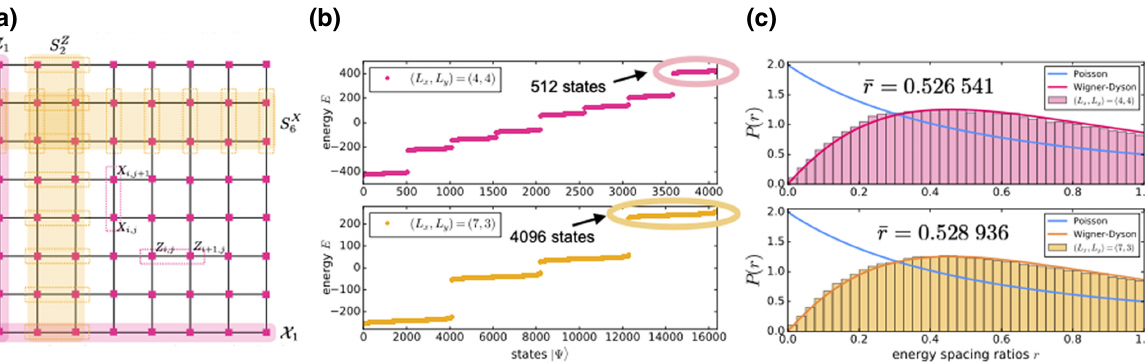
FIG. 6. The Bacon-Shor model. (a) Qubits (magenta squares) living on a square lattice with gauge generators X i , j X i , j + 1 and Z i , j Z i + 1, j highlighted by dashed rectangles. Examples of the stabilizer generators S X and S Z , i.e., S X and S Z , are highlighted in yellow and the j i 6 2 logical operators Z 1 and X 1 , each being a product of Z ( X ) operators along a vertical (horizontal) path, are highlighted in magenta. (b) The energy spectra for two systems of size ( L x , L y ) = ( 4, 4 ) (top panel) and ( 7, 3 ) (bottom panel) containing a total of 16 384 and 4096 states, respectively, are shown. The spectrum splits into eight (four) parts for ( L x , L y ) = ( 4, 4 ) , ( 7, 3 ) , each separated by a relatively large energy difference. A single sector of the spectrum contains 512 states for ( L x , L y ) = ( 4, 4 ) and 4096 states for a ( 7, 3 ) system. (c) The histograms of energy-level spacing ratios r are depicted again for the systems of size ( 4, 4 ) (top panel) and ( 7, 3 ) and J z is employed by uniformly (bottom panel). In order to lift any accidental degeneracies, mild disorder in the two bond couplings J x ij ij ∈ [0.9, 1.1] ∀ i , j with 1 ≤ i < L − 1 and 1 ≤ j < L − 1. To ensure convergence, we average over 1000 independent drawing J x , J z x y ij ij realizations of disorder for the system of size ( 4, 4 ) and over 200 disorder realizations for the ( 7, 3 ) system. The resulting histogram data closely resemble a GOE distribution, as expected. The averaged r values are ¯ r = 0.5265 and ¯ r = 0.5289 for ( L x , L y ) = ( 4, 4 ) and ( 7, 3 ) ,